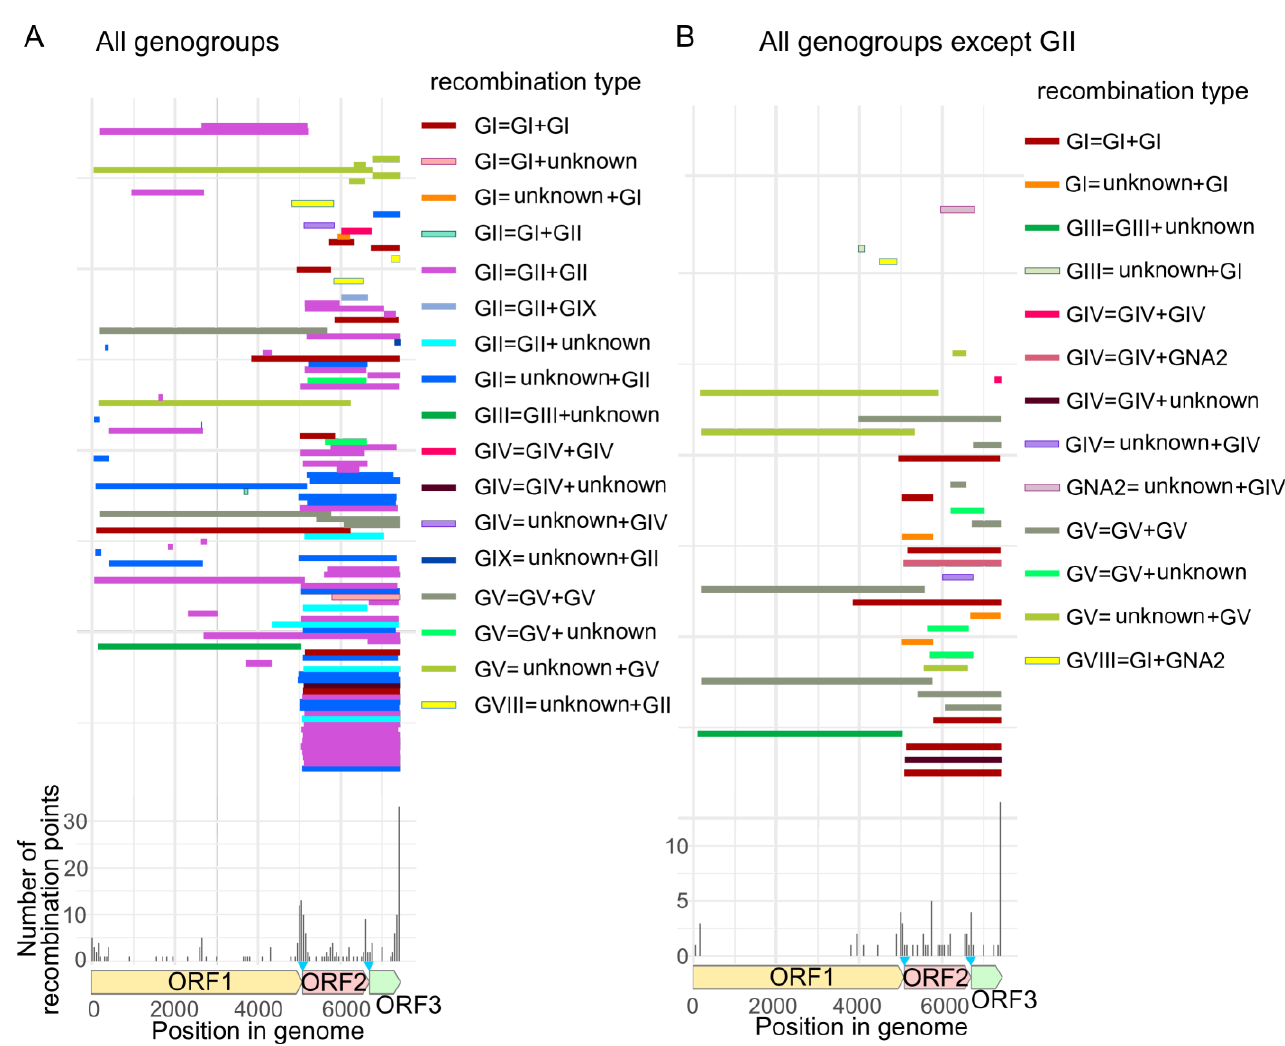
Figure 3. The distribution of recombinant fragments detected by at least four algorithms implemented in RDP4 in two datasets: ( A )—the dataset that includes all norovirus genogroups; ( B )—the dataset with all genogroups except GII. Blue triangles indicate the overlaps between ORF1 and ORF2 (17 nt), ORF2 and ORF3 (1 nt) that were duplicated in alignments of concatenated ORFs. Recombination type legend refers to the VP1 genogroups of a recombinant norovirus, and its minor and major parents (recombinant = minor parent + major parent). The lower panel shows the number of recombination breakpoints detected by RDP4 at each position of the